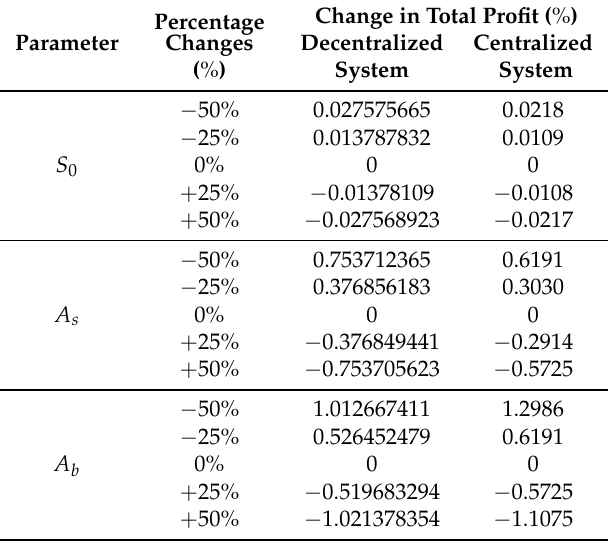
Table 7. Sensitivity analysis for numerical Problem 1, in case of reliable